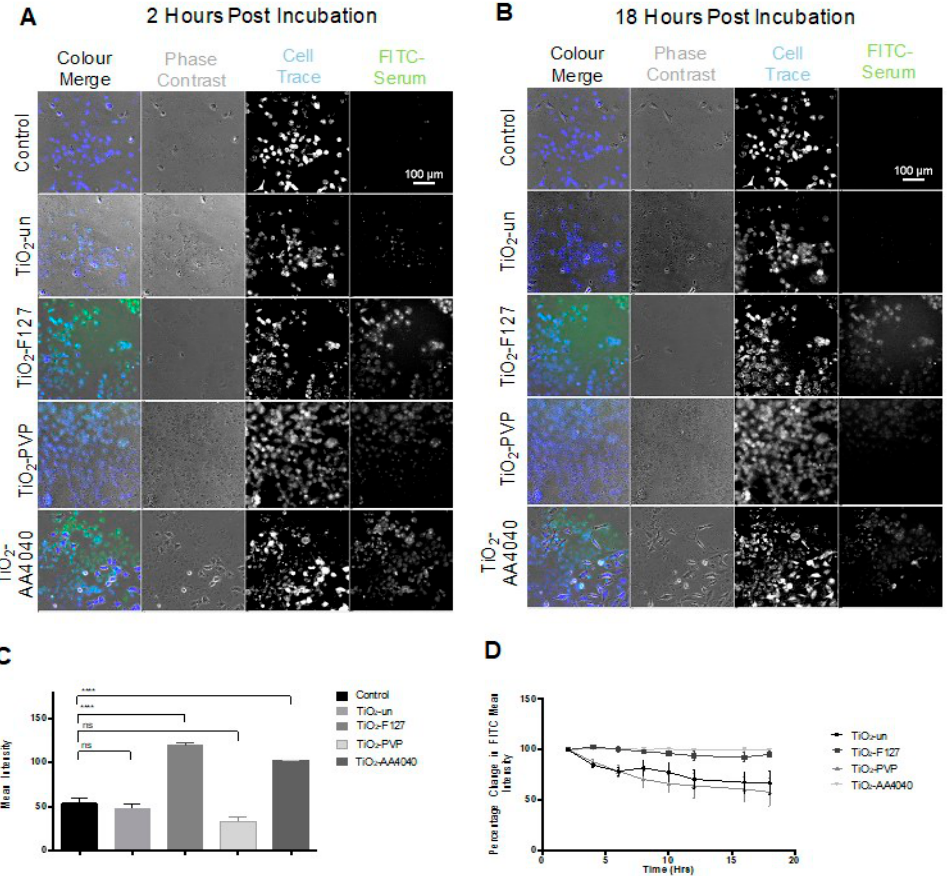
Figure 2. Biostation CT-acquired images and data showing the FITC-labeled serum intensity in A549 cells observed between 2 and 18 h post-exposure to FITC-labeled serum-containing medium in the absence of NMs (control) or with uncoated (TiO 2 -un), F127 (TiO 2 -F127), PVP (TiO 2 -PVP), or AA4040 Dispex-coated (TiO 2 -AA4040) TiO 2 NMs. ( A ) At 2 h post-incubation, a significant green signal is retained versus controls treated with FITC-serum in the absence of NMs; ( B ) at 18 h post-incubation, there is a significant loss of the FITC signal in TiO 2 -un- and TiO 2 -PVP-treated samples, while TiO 2 -F127 and TiO 2 -Dispex treatments exhibit a much smaller change. ( C ) The total raw mean FITC intensity data averaged over time showed statistically significant di ff erences in intensity between the control, TiO 2 -F127, and TiO 2 -AA4040 NMs when treatment groups were compared to control with an unpaired t-test ( p < 0.001). Significance was not observed when controls were compared to cells treated with TiO 2 -un and TiO 2 -PVP NMs. ( D ) Normalizing mean intensity data to a percentage change in signal between subsequent time points shows no significant change in the FITC-serum intensity in TiO 2 -AA4040- and TiO 2 -F127-treated cells, suggesting the retention of an FITC-labeled serum corona. Comparatively, TiO 2 -un- and TiO 2 -PVP-coated NMs show a progressive loss of FITC signal over the time observed. Log transformation of the percentage change allows for analysis of the data set with a repeated measures ANOVA test indicating significance ( p = 0.0250) in variance across NMs, and significance ( p = 0.018) in variance across time (two-way ANOVA, SEM, n =